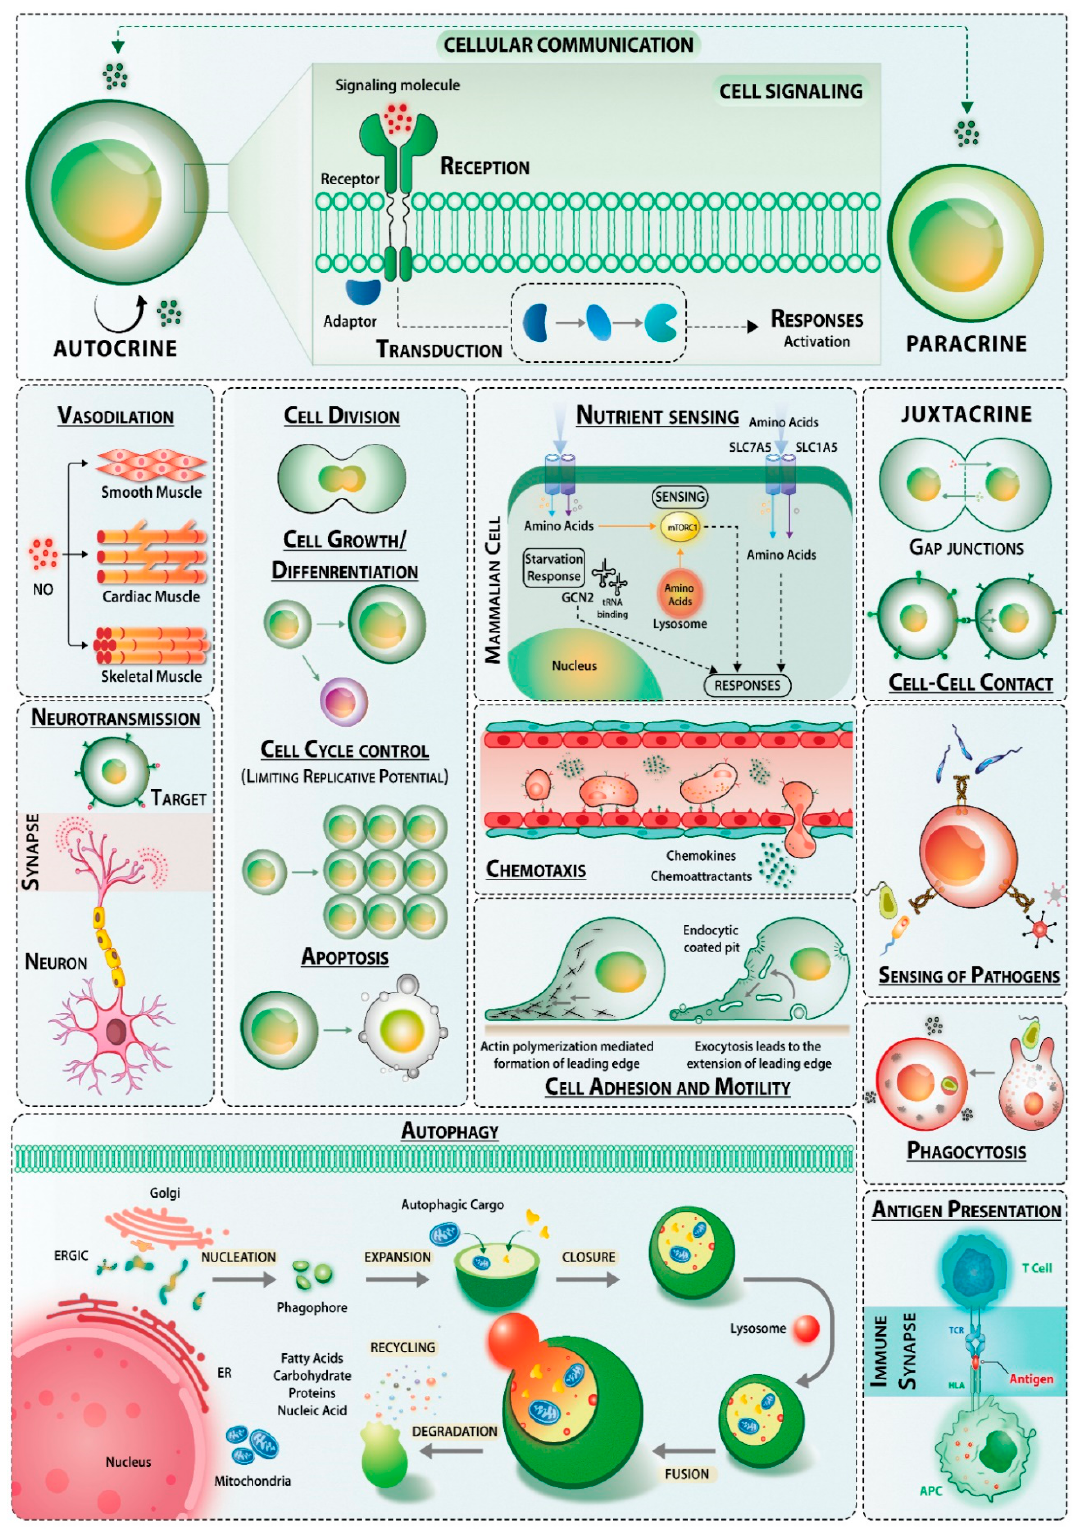
Figure 1. Cellular signaling controls various aspects of multicellular life forms. Not only the key biological processes such as cell division, differentiation, growth, and cell-cycle transition, but also specialized cell-specific functions such as neurotransmission, pathogen-sensing, phagocytosis, and antigen-presentation are controlled by specific signaling pathways. The process of autophagy and nutrient cycling and recycling are some accessory pathways that are triggered by definitive signaling cues.